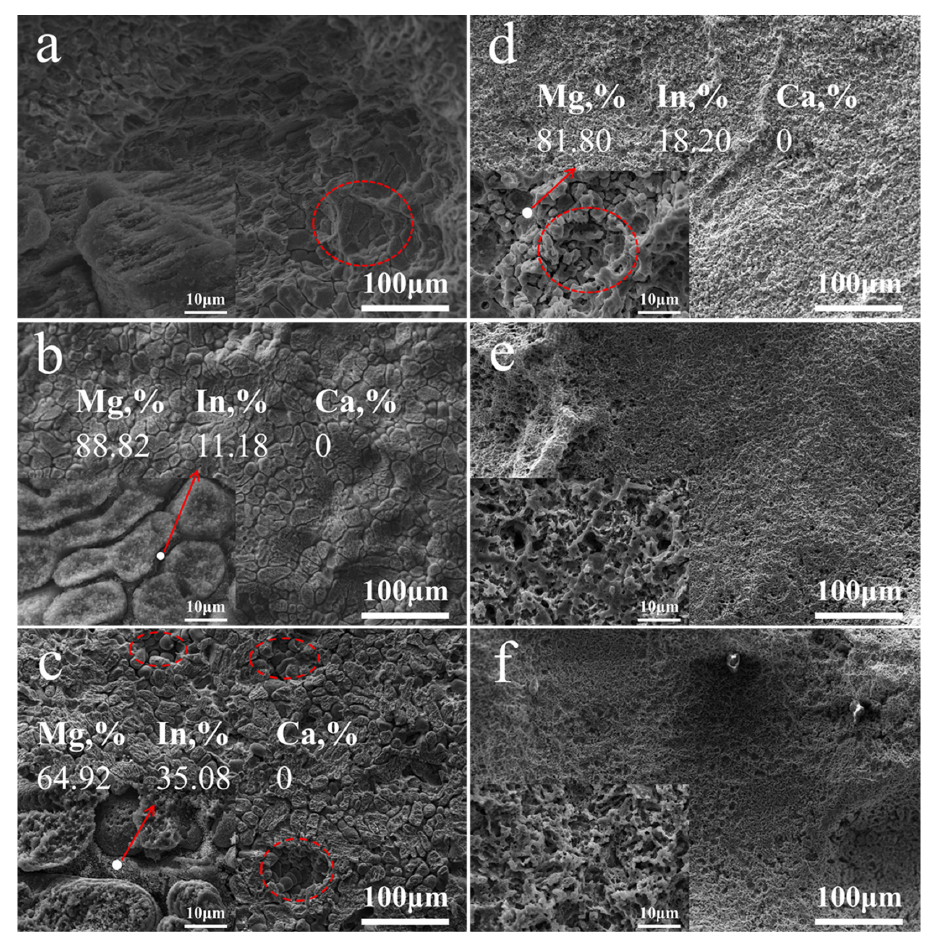
Figure 6. Corrosion morphologies of Mg-In-Ca alloy discharged in 3.5% NaCl solution for 5 h at current density of 30 mA cm − 2 : ( a ) as-cast IC31 alloy; ( b ) as-cast IC33 alloy; ( c ) as-cast IC35 alloy; ( d ) extruded IC31 alloy; ( e ) extruded IC33 alloy; ( f ) extruded IC35 alloy.